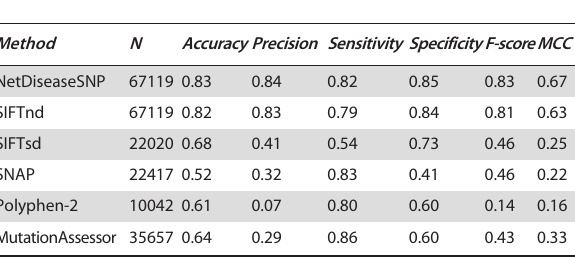
Table 3. Benchmark of NetDiseaseSNP: SIFT PSSMs.